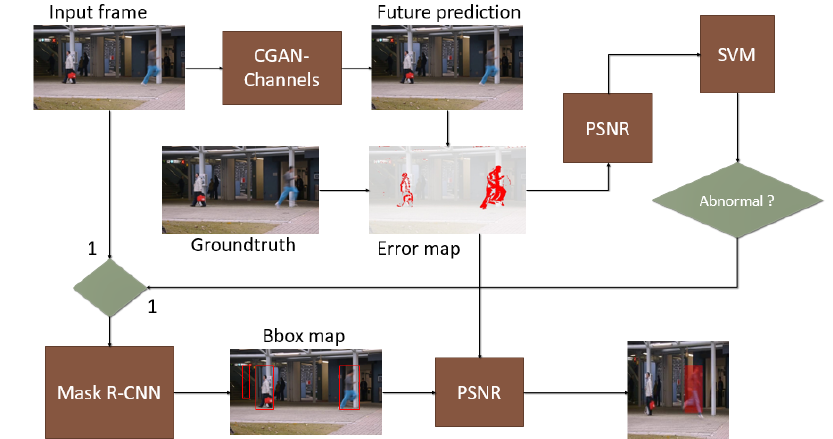
Figure 3. The pipeline of object-centric anomaly localization framework. After the frame-level anomaly detection stage, we obtain the labels for each frame. Only positive samples (i.e., abnormal frame) are taken into account to localization stage. For each abnormal frame, we run a fast detector to compute bounding boxes (BB) for each object in the sequence. To speed up the computational complexity in practical experiments, we do not re-pass each BB throughout whole framework but we apply directly each BB to error maps. PSNR scores are computed for each one. The BBs yielding minimum values for PSNR scores or values smaller than a threshold refer to the abnormal